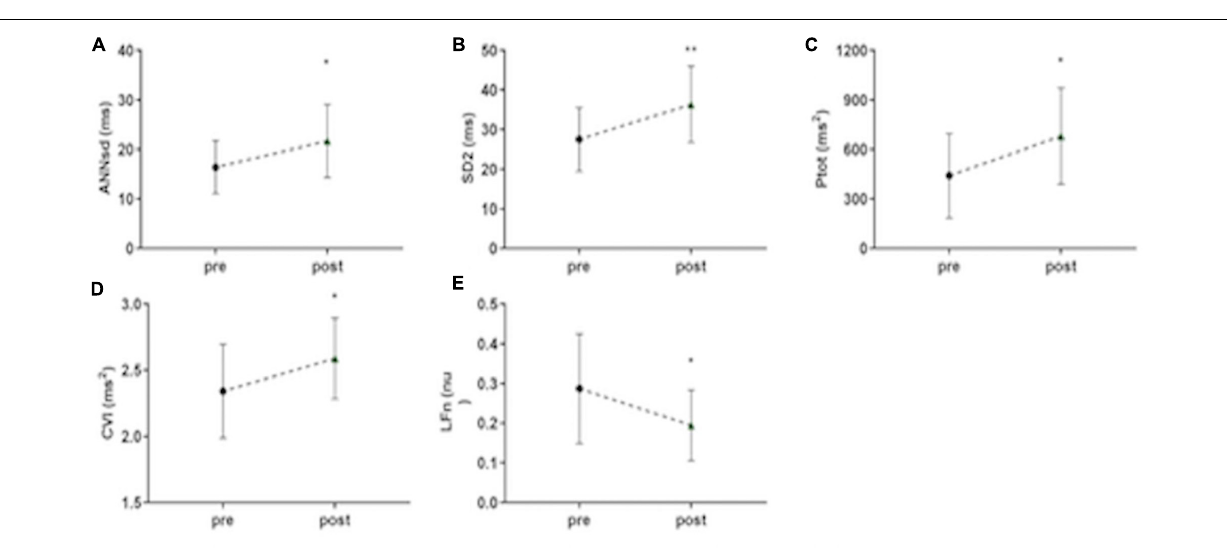
FIGURE 4 | Persistent short-term musical modulation of ANS activity. (A) ANNsd (ms): standard deviation of the Average NN; (B) SD (ms): standard deviation perpendicular to the line of the identity of Poincairè Plot; short term variability, mainly controlled by parasympathetic tone; (C) Ptot (ms2): total power of fetal RR series, index of total HRV, mainly controlled by sympathetic tone; (D) CVI (ms2): Cardiac Vagal Index, the contribution of the parasympathetic nervous system to cardiac regulation; (E) LFn: low-frequency band (0.04–0.15 Hz) normalized for the total power; low-frequency band mainly controlled by sympathetic tone; pre: basal FANTE data collection; stimulus: stimulus FANTE data collection; post; post-stimulus FANTE data collection. *significant at the alpha level p < 0.05; **significant at the alpha level p <